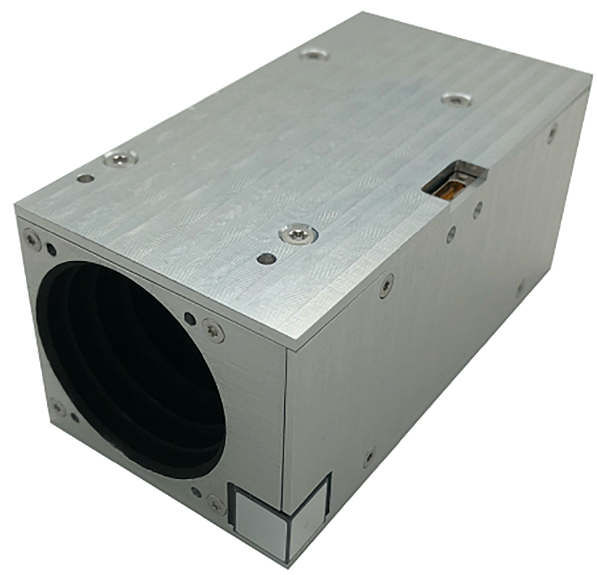
Figure 16. Sagitta Star Tracker, (Credits to ARCSEC SPACE).